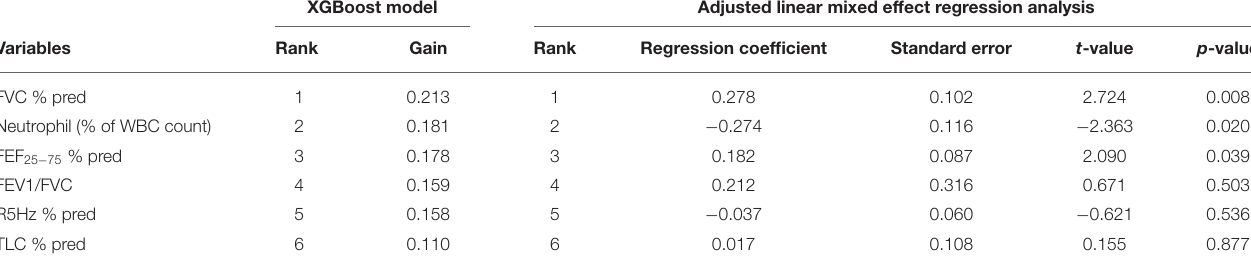
TABLE 3 | The ranking of the predictors of DLCO.